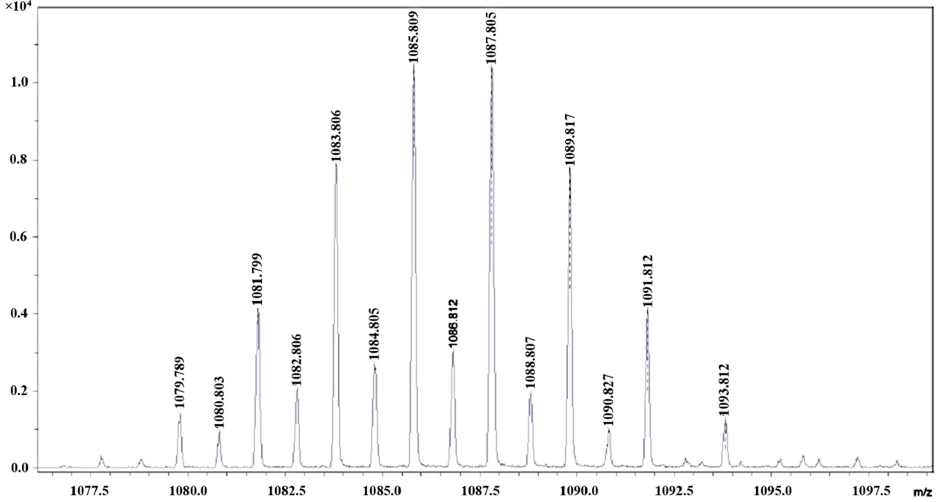
Figure 1. MALDI-TOF mass spectrum of 1 in trans -2-[3-(4- tert -butylphenyl)-2-methyl-2- MALDI-TOF mass spectrum of 1 in trans -2-[3-(4- tert -butylphenyl)-2-methyl-2- propenylidene]malononitrile (DCTB) (fragment [W 2 Br 9 ] ´ ). Table 1. Fragments ( m / z ) of 1 . Table 1. Fragments ( m / z ) of 1